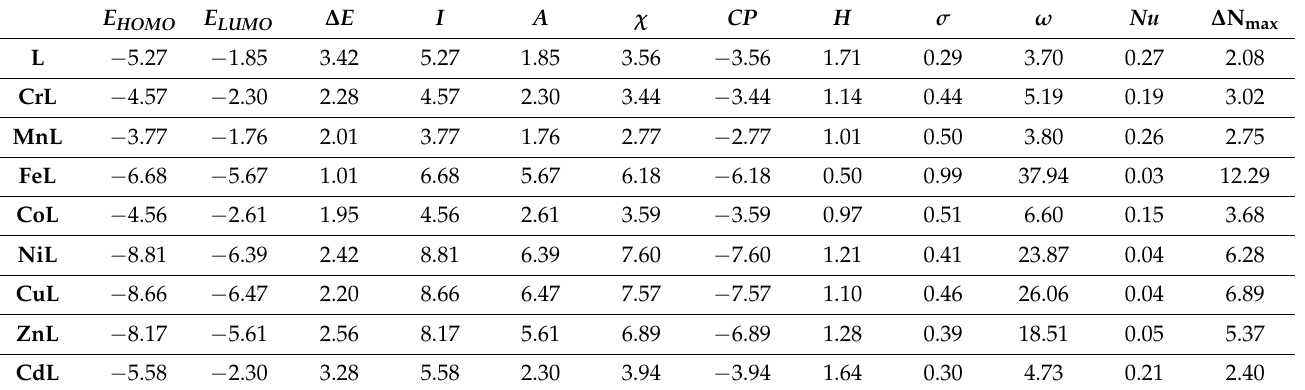
Table 1. Chemical descriptors calculated using